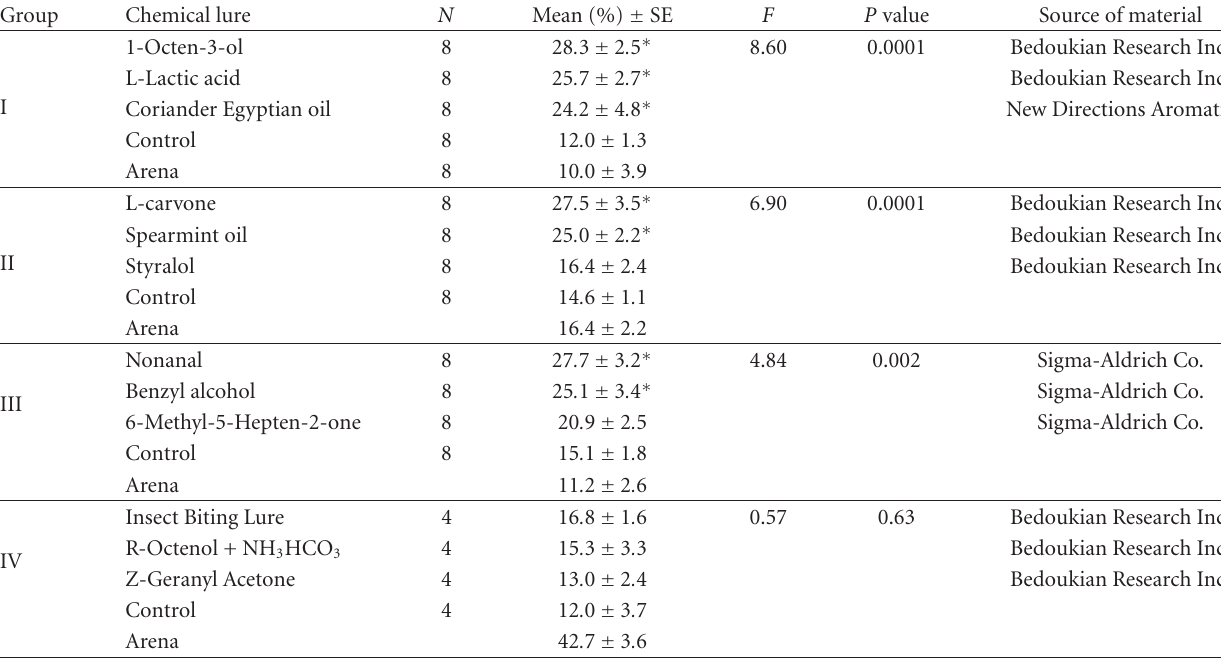
Table 1: Percent bed bugs in pitfall traps baited with three chemical lures and an unbaited control in each arena.